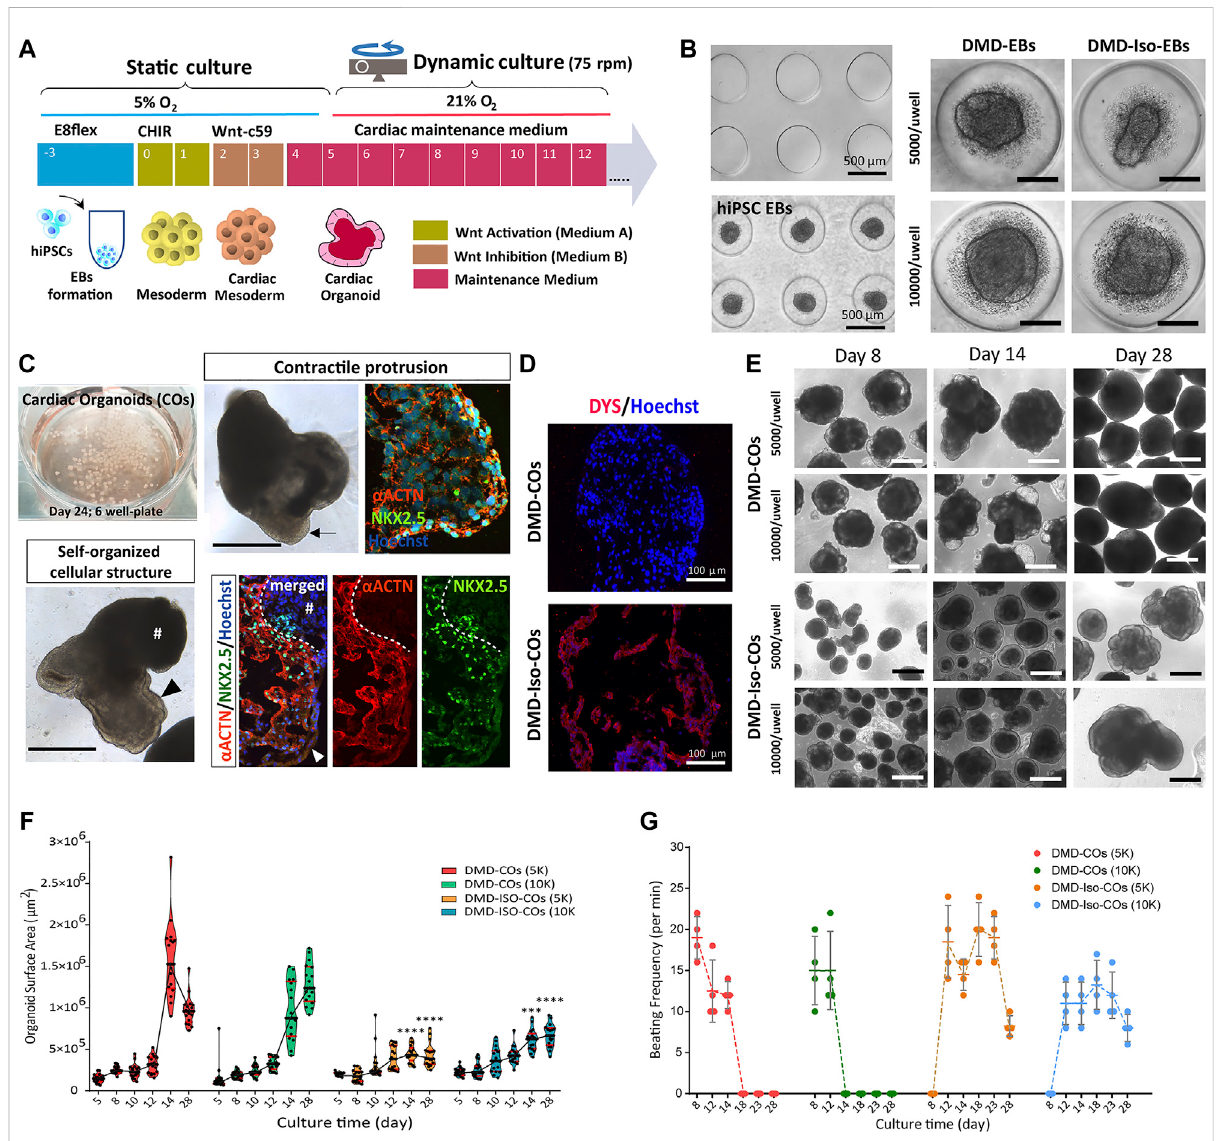
FIGURE 2 Generation of DMD-COs and DMD-Iso-COs from patient-derived hiPSC. (A) Schematic showing the culture protocol to generate DMD-COs and DMD-Iso-COsfrompatient-derivedhiPSCembryoidbodies(EBs). (B) Bright fi eldimagesofthemicrowellsoftheagaroseinsertandtheformedEBs. (C) EBs pooled from two agarose inserts inside a well of six-well plate for dynamic culture, and the morphology of COs at high magni fi cation showing contractile cardiomyocyte protrusion (arrow) and distinct self-organized cellular structure at the organoid periphery (arrowhead) both with speci fi c spatial distributionofNKX2.5and α ACTNpositivity.Non-translucentorganoidstructure(#)wasnegativeforNKX2.5and α ACTN. (D) Immuno fl uorescencestaining showing the localization of DYS in DMD-Iso-COs, which was undetectable in DMD-COs. Nuclei were counterstained with Hoechst. (E) Representative images of CO morphology and the changes of organoid size (generated at two cells seeding numbers) over 28 days of dynamic culture. (F , G) Effect of cell seedingnumbersonthegrowth( n =17)andthebeatingfrequency( n =4)ofDMD-COsorDMD-Iso-COsover28 days.DMD-COsversusDMD-Iso-COsat 5K (5,000 cells/microwell) or 10K (10,000 cells/microwell). Statistical analyses were performed by two-way ANOVA with Tukey ’ s multiple comparisons: *** p < 0.001, **** p < 0.0001. CO, Cardiac organoid; DMD-COs and DMD-Iso-COs, cardiac organoids from DMD patient-derived hiPSC and isogenic corrected hiPSC, respectively. Scale bar = 1 mm or as stated in the fi